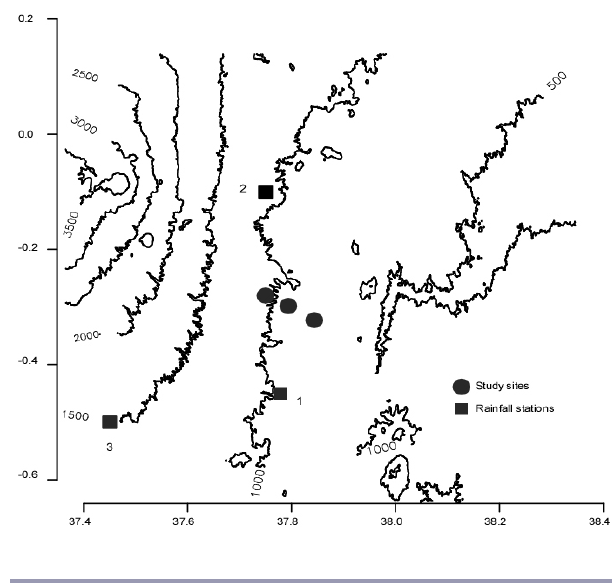
Fig. 1 . Study site, eastern slope of Mount Kenya. Farmers surveyed (solid circles) and rainfall stations (solid squares): 1. Ishiara (872 m); 2. Mitunguu (1189 m); 3. Embu (1433